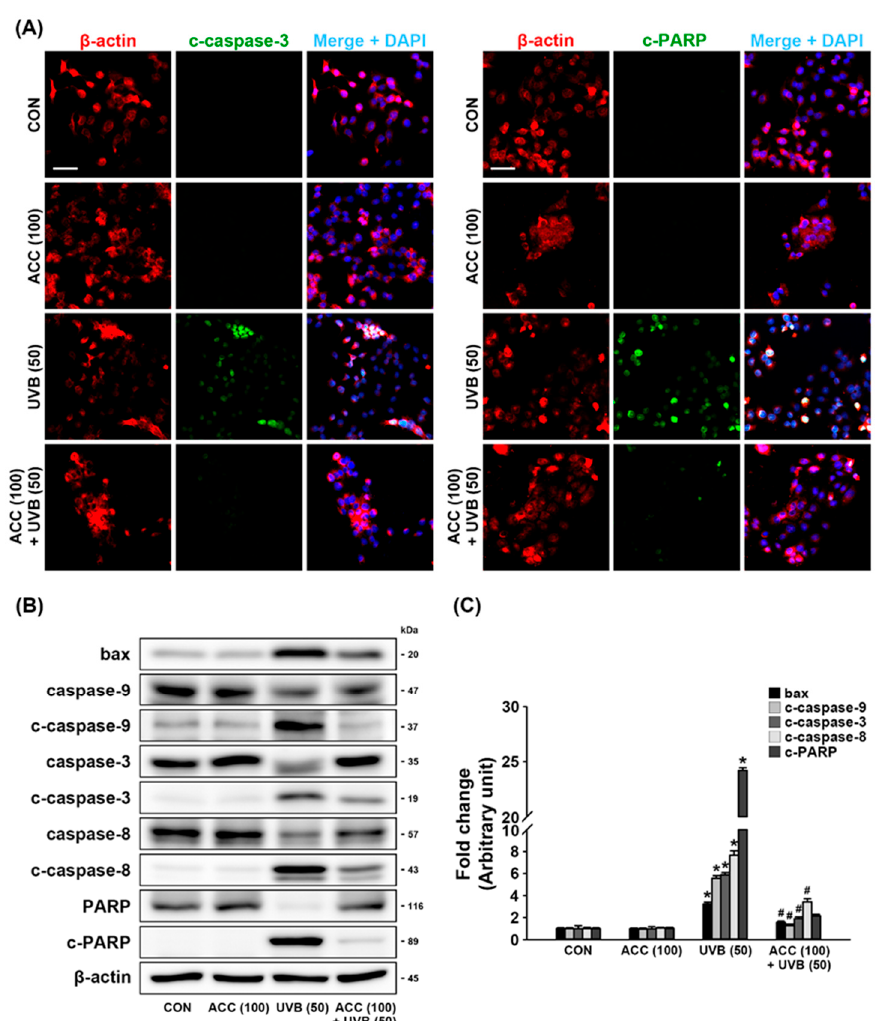
Figure 7. Antiapoptotic effect of ACC in UVB-irrdiated HaCaT cells. ( A ) Representative images of immunofluorescence labeling for β -actin (red) and cleaved-caspase-3 (c-caspase-3; green) or β -actin and cleaved-poly (ADP-ribose) polymerase (c-PARP; green) in UVB-irradiated (50 mJ/cm 2 ) HaCaT cells. Scale bar, 50 µm. ( B , C ) Effects of bax, caspase-9, c-caspase-9, caspase-3, c-caspase-3, caspase-8, c-caspase-8, PARP, and c-PARP in UVB-irradiated (50 mJ/cm 2 ) HaCaT cells. Bax, caspase-9, c-caspase-9, caspase-3, c-caspase-3, caspase-8, c-caspase-8, PARP, and c-PARP were measured at 1 day after UVB irradiation of HaCaT cells. * p < 0.001 vs. CON; # p < 0.001 vs. UVB. All experiments were repeated at least three times, and similar results were obtained.